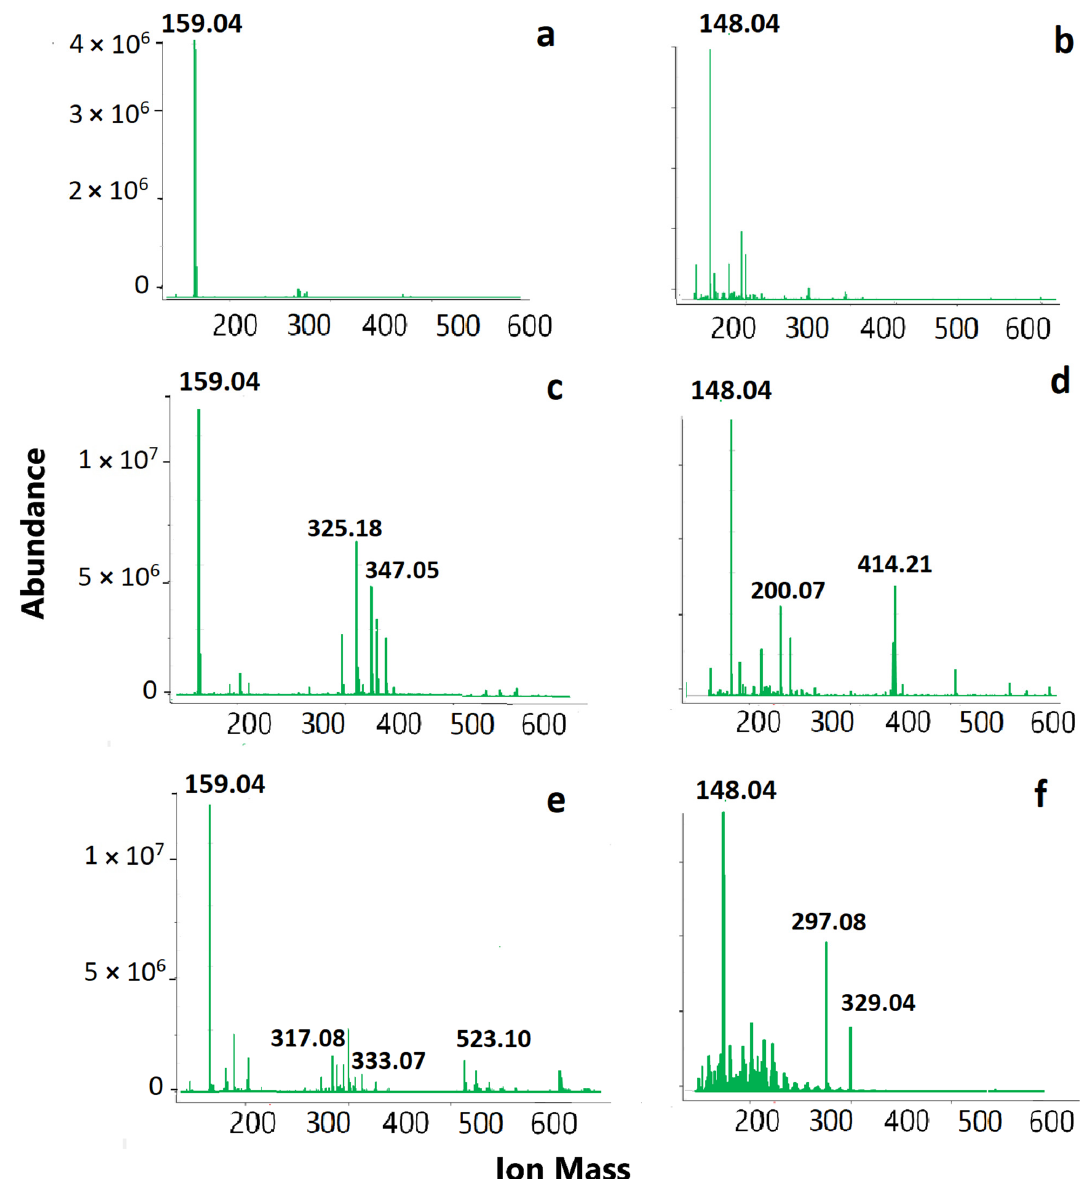
Figure 3. Mass spectra for original (non-irradiated) 1,8-DHN ( a ) and 5,6-DHI ( b ), post-irradiation samples: 1,8-DHN ( c ), and 5,6-DHI ( d ), 1,8-DHN with 5% H 2 O 2 ( e ), 5,6-DHI with 5% H 2 O 2 ( f ) in (-) ESI mode. All samples were diluted in water by 1:20. Original 1,8-DHN solution: pH = 6.0, original 5,6-DHI solution: pH = 6.5, aged 1,8-DHN: pH = 7.0, aged 5,6-DHI: pH = 7.0. m/z values are indicated in each mass spectrum.